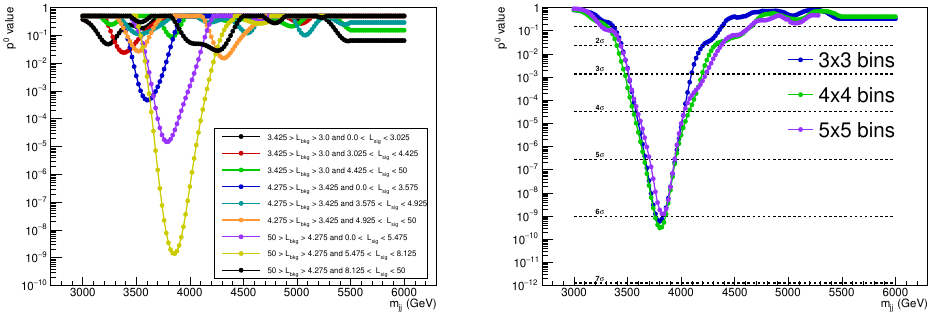
Figure 8 . Scan of the significance of an excess quoted in the p-value significance of a Gaussian resonance on top of a fitted background using the asymptotic CLs method for (Left) individual categories in L sig and L bkg , and (Right) combined categories using a uniform populated set of 9 bins (3 in L sig , 3 in L bkg ) 16 bins (4,4), and 25 bins